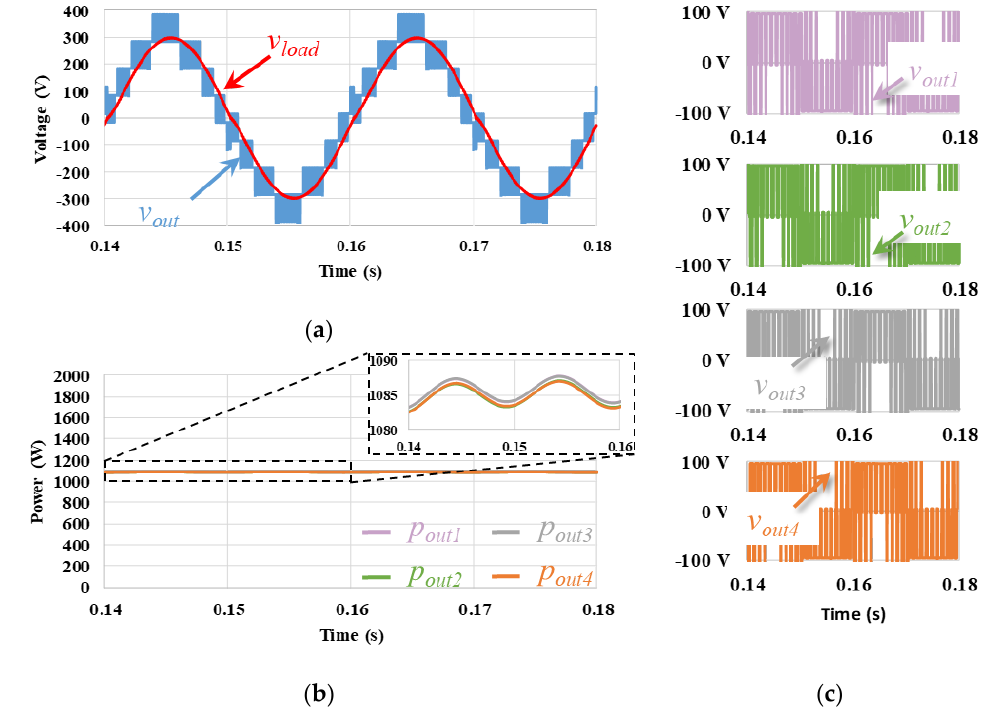
Figure 22. Simulation results of the PSC PWM technique: ( a ) output voltage of the cascaded MLC, v out , and load voltage, v load ; ( b ) output power on each submodule ( p out1 , p out2 , p out3 , p out4 ); ( c ) output voltage on each submodule ( v out1 , v out2 , v out3 , v out4 ).